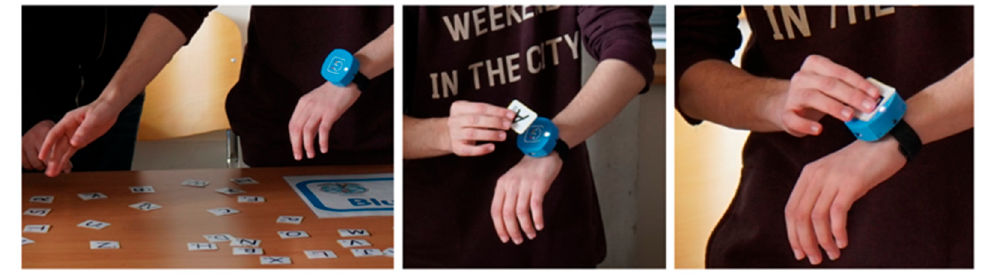
Figure 12. MovED interaction. Figure 12. MovED